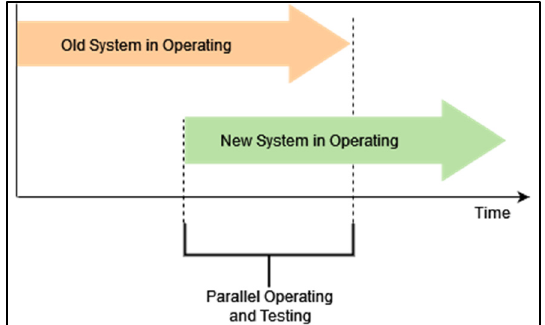
Figure 3. Parallel running process.